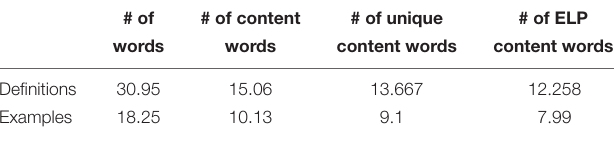
TABLE 1 | Descriptive statistics of UD definition and